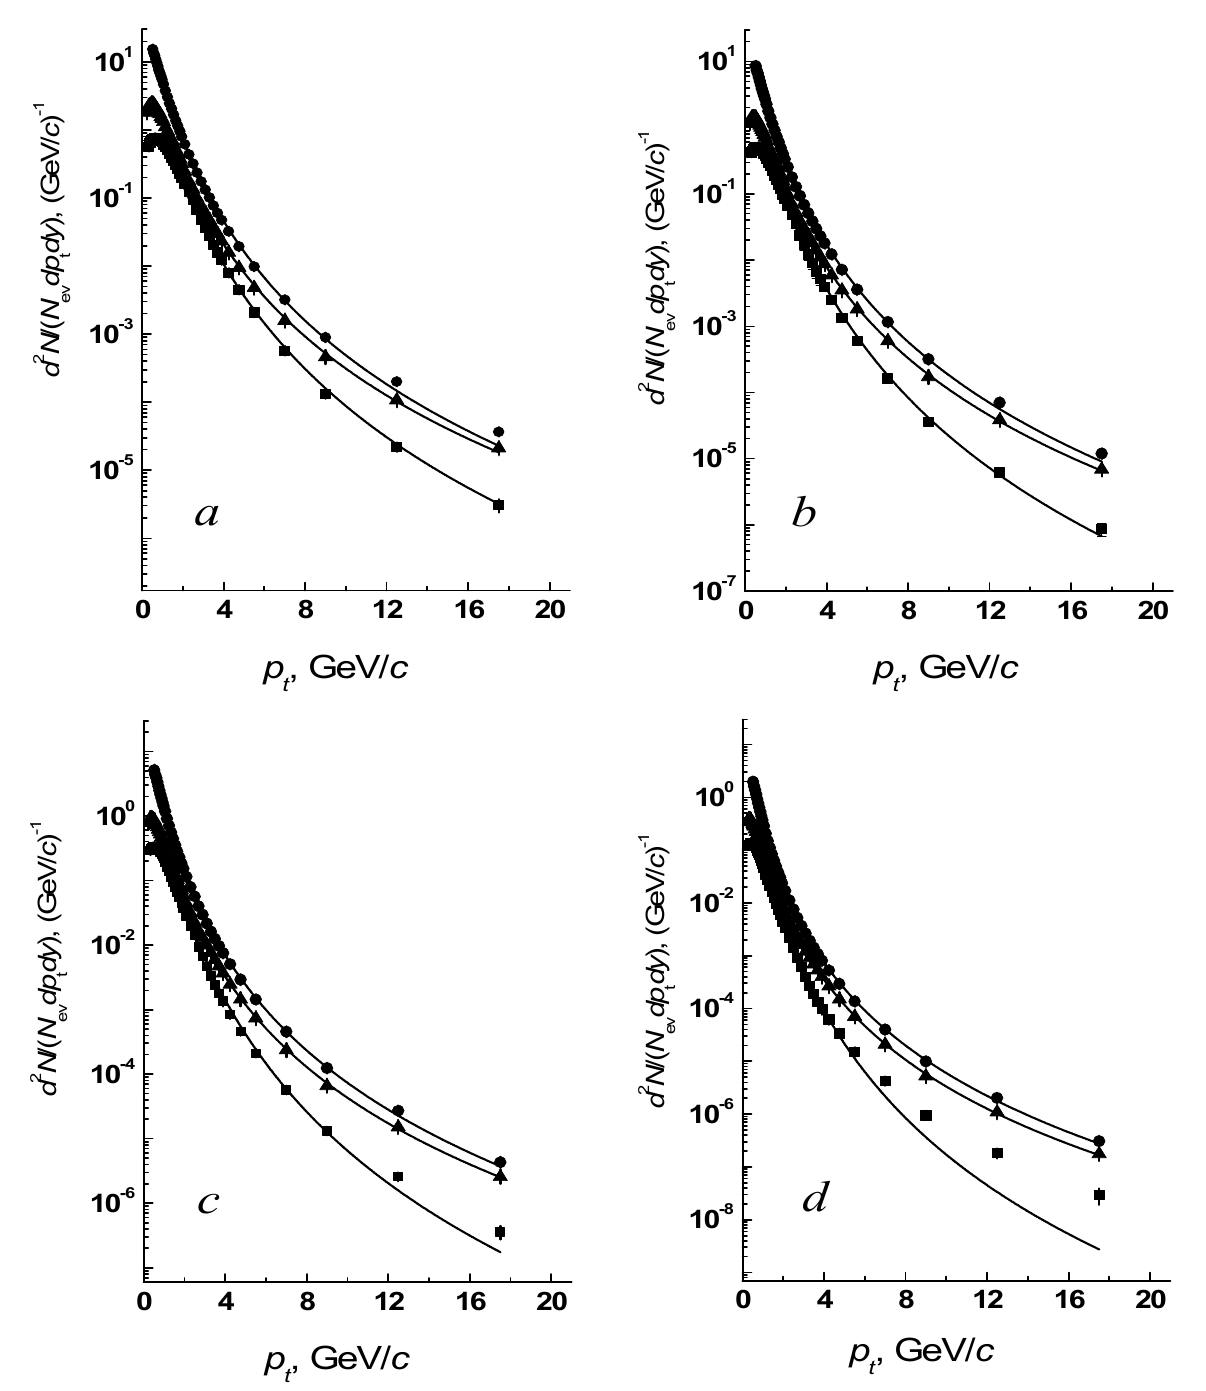
Figure 1. The combined minimum 𝜒2 fits (solid curves) with the function in Equation (6) of the experimental mid- y p t distributions of the charged pions ( ● ) and kaons ( ▲ ), protons and antiprotons ( ■ ) in proton–proton collisions at ( s ) 1/2 = 7 TeV in various groups of < dN ch / d η >: < dN ch / d η > = 21.3 ± 0.6 ( a ), < dN ch / d η > = 11.5 ± 0.3 ( b ), < dN ch / d η > = 6.72 ± 0.21 ( c ), and < dN ch / d η > = 2.26 ± 0.12 ( d ). The vertical error bars are combined statistical and systematic errors, dominated by the systematic ones.